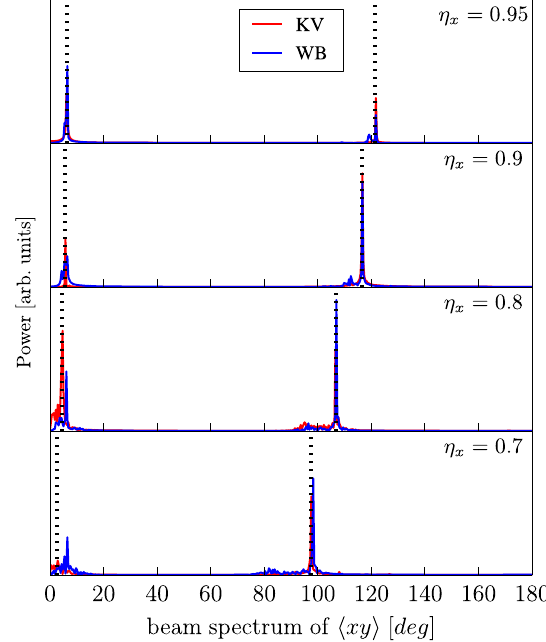
1 ; 2 and odd FIG. 3. Elliptical beam case, k 0 ;x ¼ 60 °, k 0 ;y ¼ 66 . 7 °: Beam spectrum of h xy i from PIC simulation of KV distribution (red solid) and waterbag (WB) distribution (blue solid), compared with the analytical results (dotted black lines) of phase shifts of second order odd sum and difference modes ψ 1 ; 2 , for different values of η x in a constant focusing channel.